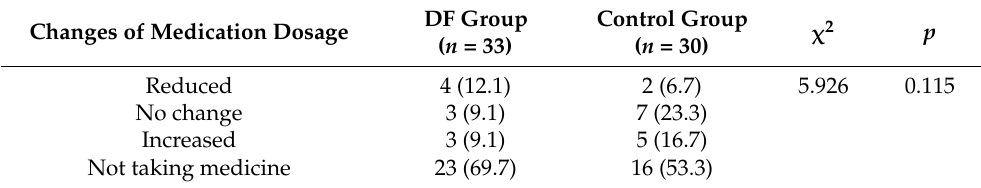
Table 6. Comparison of the HR-lowing drug ( β -receptor blocker/calcium ion antagonist) at 3 m between two